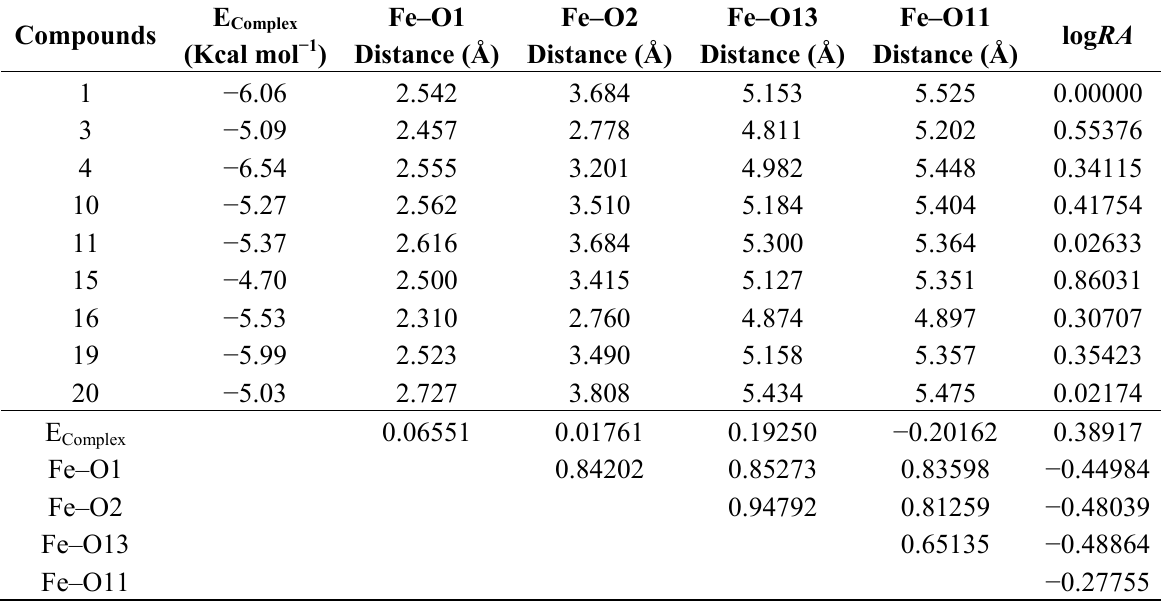
Table 2. Parameters calculated by molecular docking of heme-artemisinin and most active